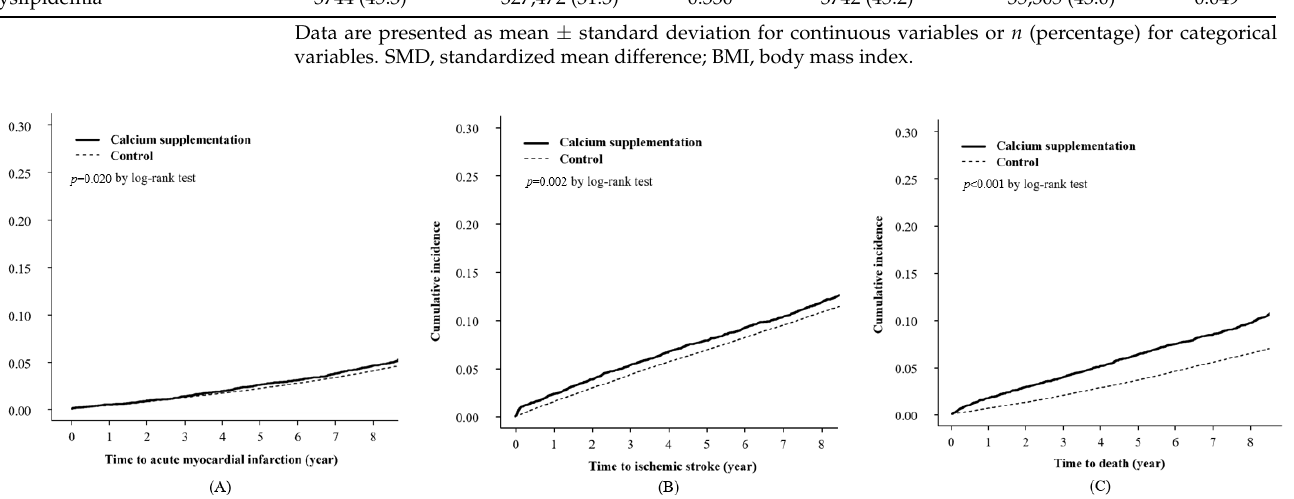
Data are presented as mean ± standard deviation for continuous variables or n (percentage) for cat-